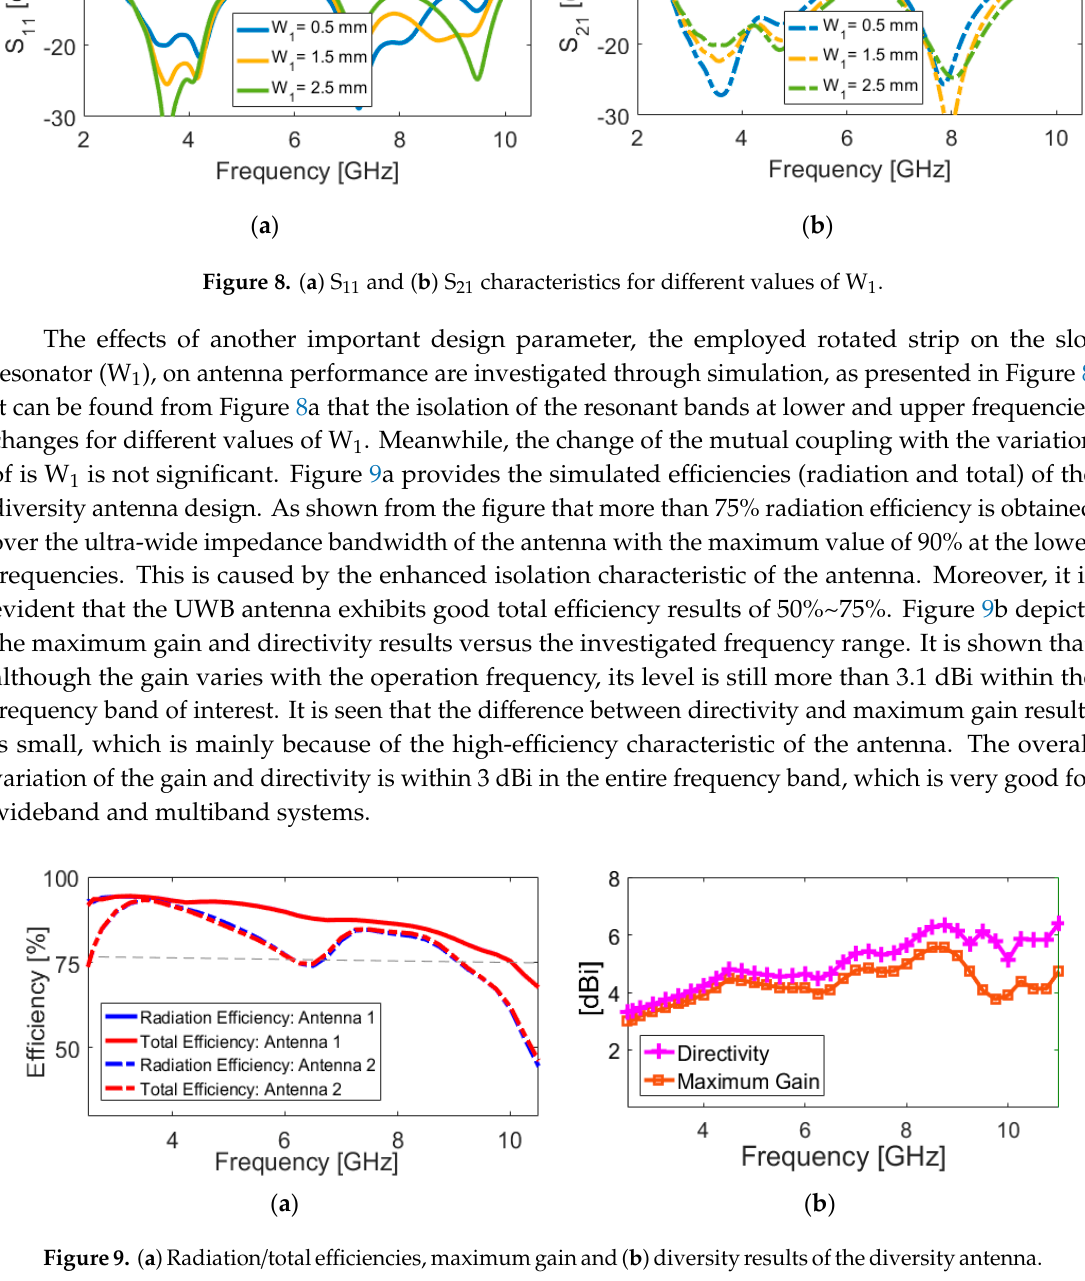
Figure 7. ( a ) S 11 and (b ) S 21 characteristics for different values of r 1 .